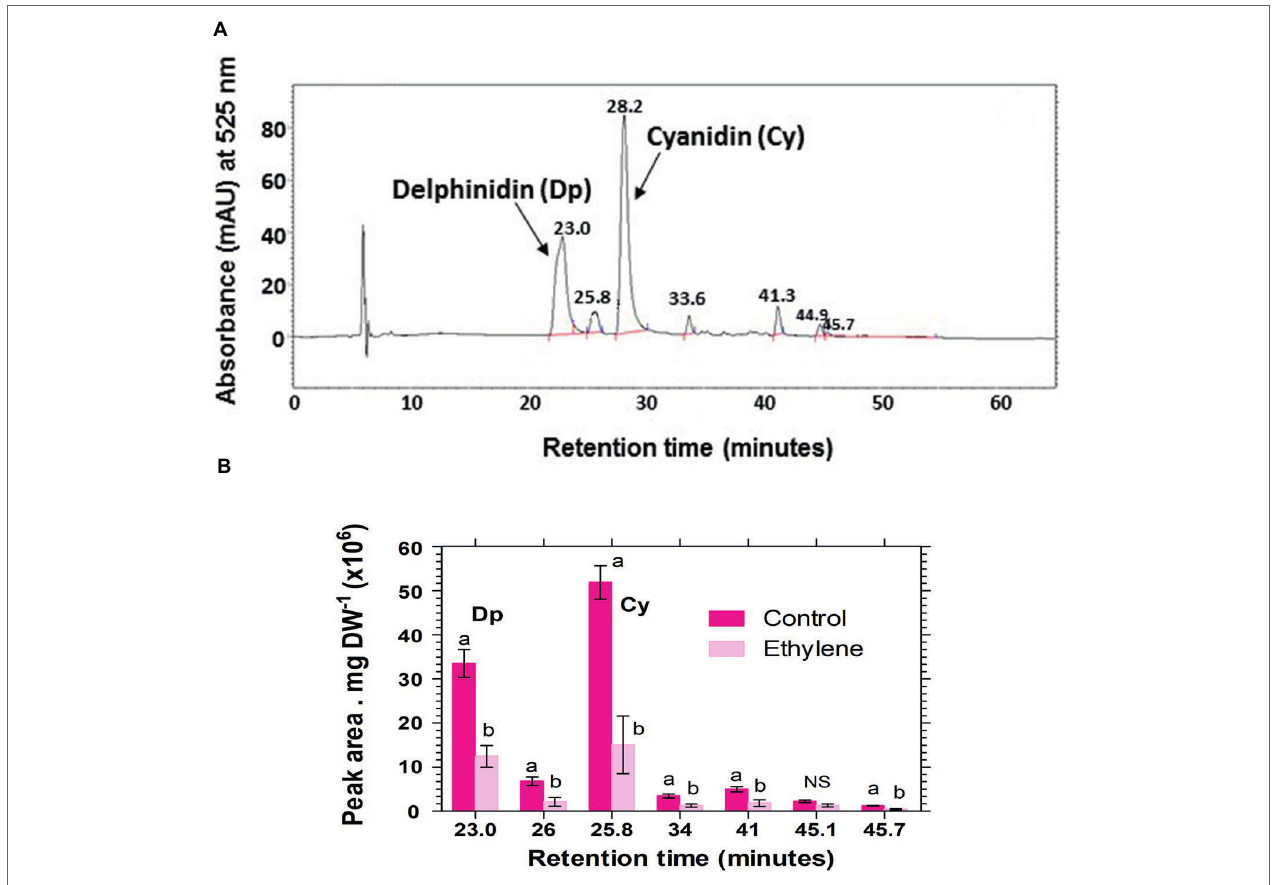
FIGURE 6 | A typical chromatogram profile of anthocyanidins detected in control hydrolyzed samples of Vanda ‘Sansai Blue’ florets (A) , and effect of ethylene treatment on the levels of these anthocyanidins, detected 2 days after treatment (B) . The inflorescences were exposed either to air (control) or to 10 μl L −1 ethylene for 24 h at 21 ± 2 ° C. Anthocyanins were extracted from florets at the bloom developmental stage (see Figure 1A ), 2 days after treatment, hydrolyzed, purified and chromatographed. The results in graph (B) represent means ± SE of three floret replicates per treatment, and different letters indicate significant differences among treatments at the different time points, at p < 0.01 (for 21.44, 25.57, 45.7 min RT), or at p < 0.05 (for 37.43, 28.4, 34.37 min RT); NS, not significant. Dp, Delphinidin; Cy,